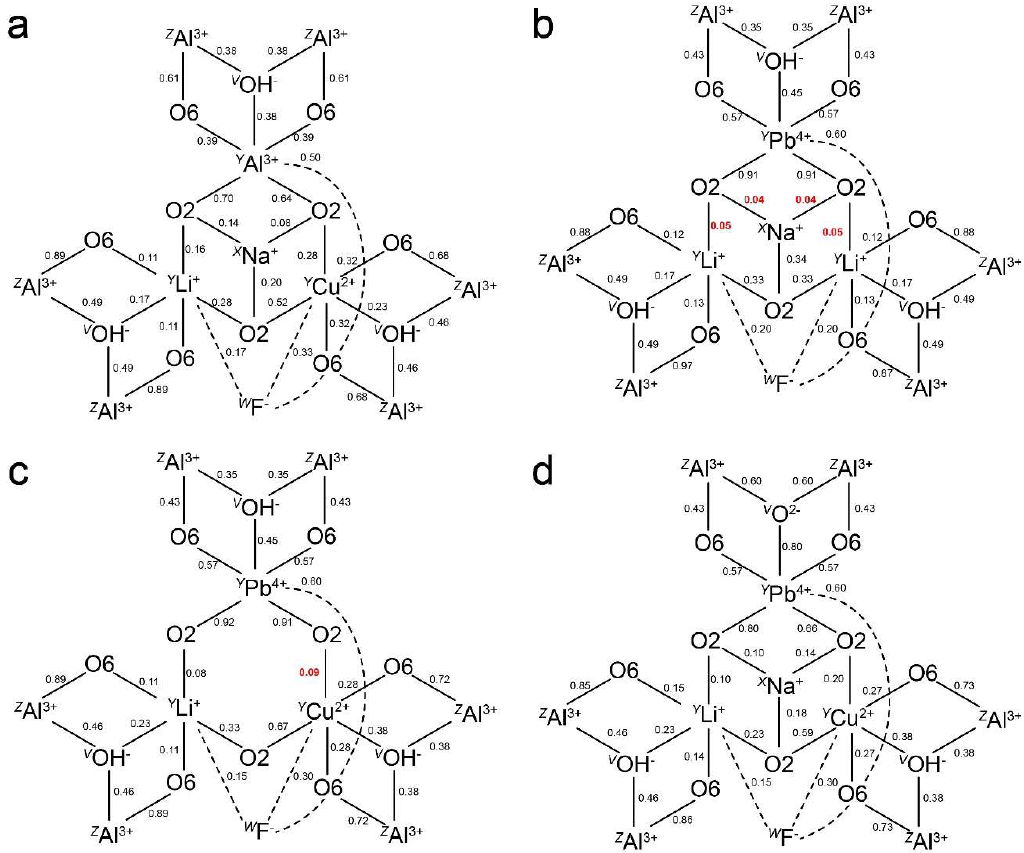
Figure 10. Structural arrangement graphs of the Y-site neighborhood in the structure of ( a ) Cu-bearing elbaite and arrangements derived by ( b ) Pb 4 + Li 1 + (Al 3 + Cu 2 + ) − 1 , ( c ) Pb 4 + (cid:3) (Al 3 + Na 1 + ) − 1 and